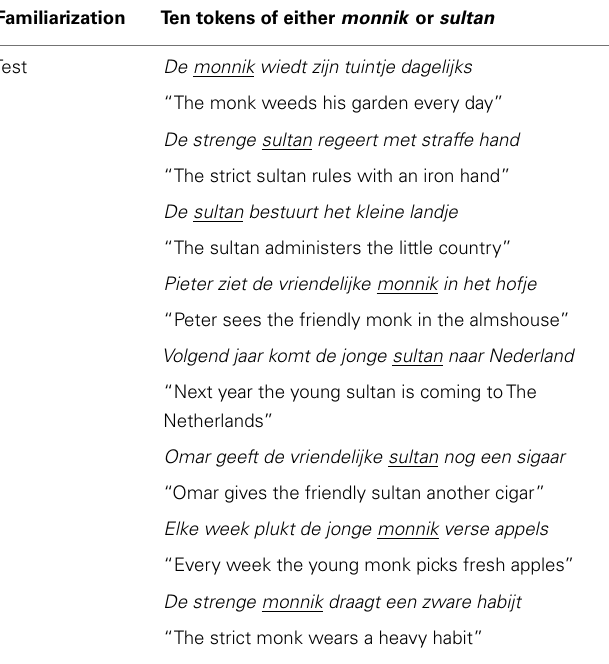
Table 1 |An example of an experimental trial in the ERP study, with English